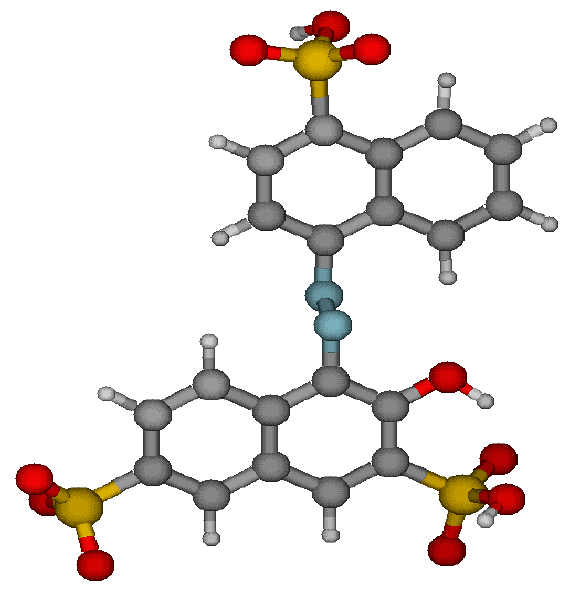
Figure 8. Ball and stick atomic model of Amaranth.